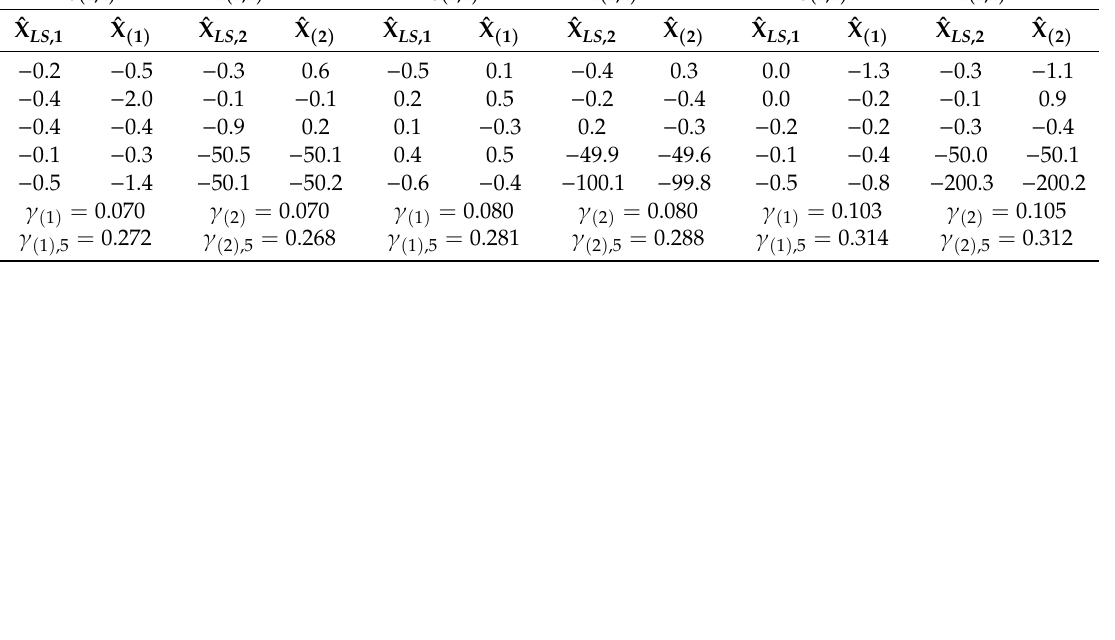
Table 2. The MC estimates of the point heights and SRs for two unstable points.